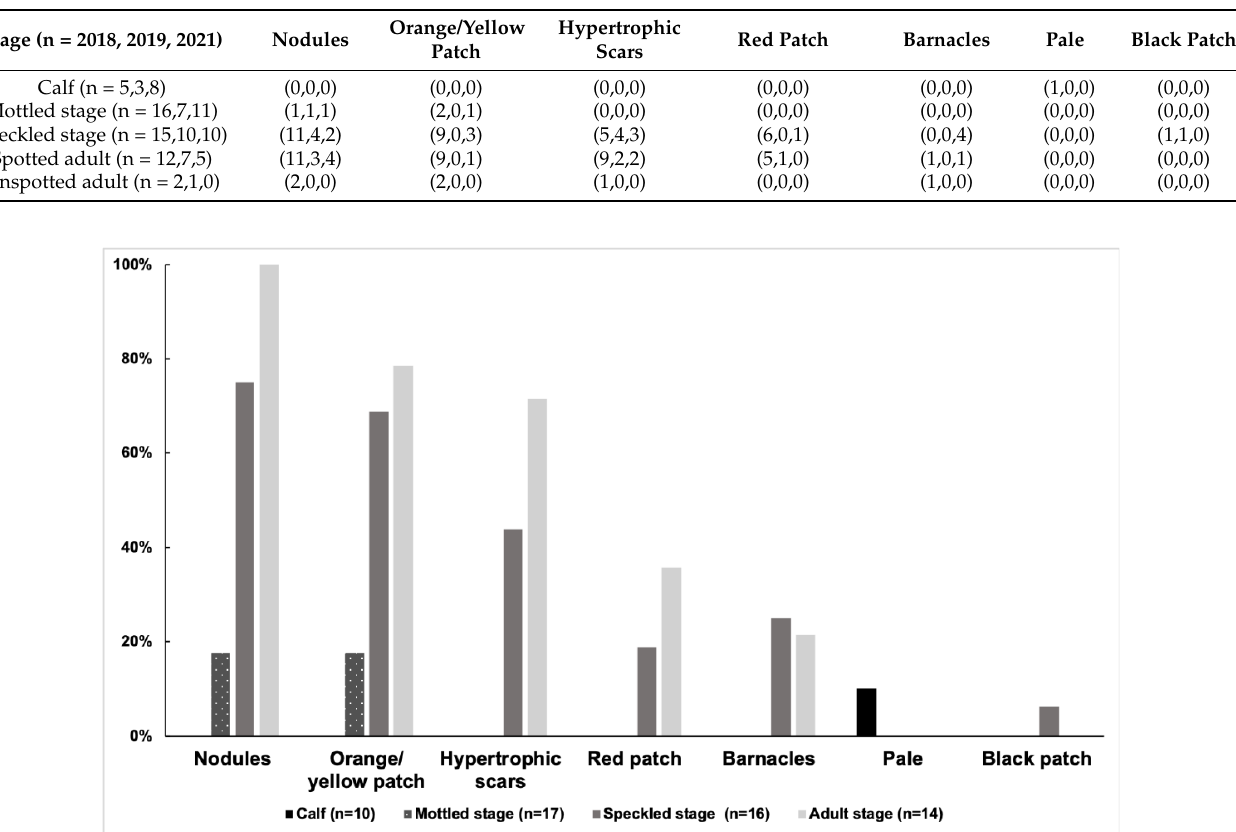
Figure 6. The prevalence of different skin lesion categories in each coloration stage from 2018 to 2021 (n =